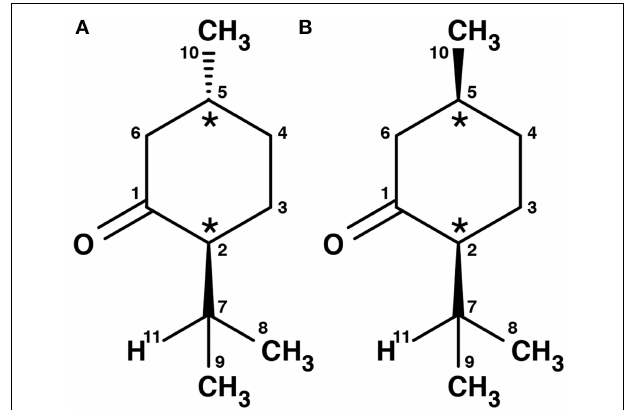
FIGURE 2 | Schemes of the structures of the (-)-enantiomers of (A) (-)-menthone, (B) (-)-isomenthone. The two stereogenic centers are marked with